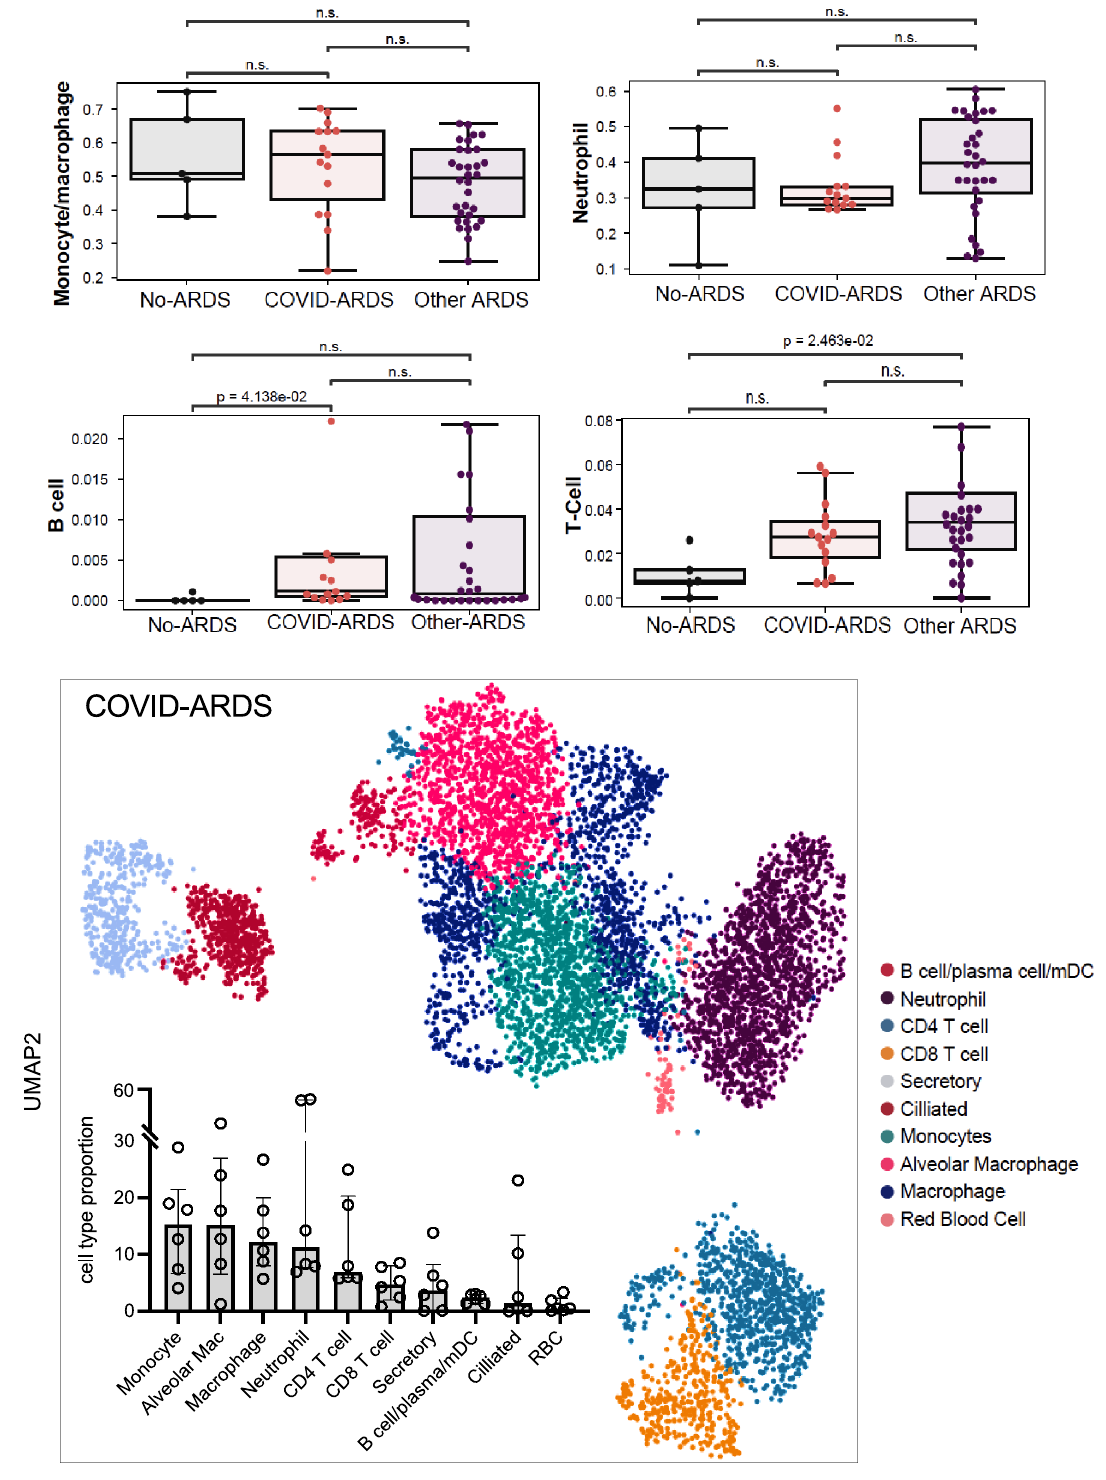
Fig. 2 Cellular landscape of COVID-19 ARDS. a In silico deconvolution of cell types from tracheal aspirate bulk RNA-sequencing data using lung single-cell signatures. The horizontal line inside the box denotes the median and the lower and upper hinges correspond to the fi rst and third quartiles, respectively. Pairwise comparisons between patient groups were performed with a two-sided Mann – Whitney – Wilcoxon test followed by Bonferroni correction ( n = 15 COVID-ARDS, n = 32 Other-ARDS, n = 5 No-ARDS). Data for other cell types examined are plotted in Supplementary Fig. 4 and tabulated in (Supplementary Data 7). b UMAP demonstrating the immune cell landscape of COVID-19 ARDS from scRNAseq of TA specimens. Inset demonstrates cell-type proportions ( n = 6, COVID-ARDS group). The bar plot denotes median and the error bars depict the interquartile range, respectively. Mac alveolar macrophage, mDC monocyte-derived dendritic cell, RBC red blood cell. Source data are provided in the Source Data fi le.